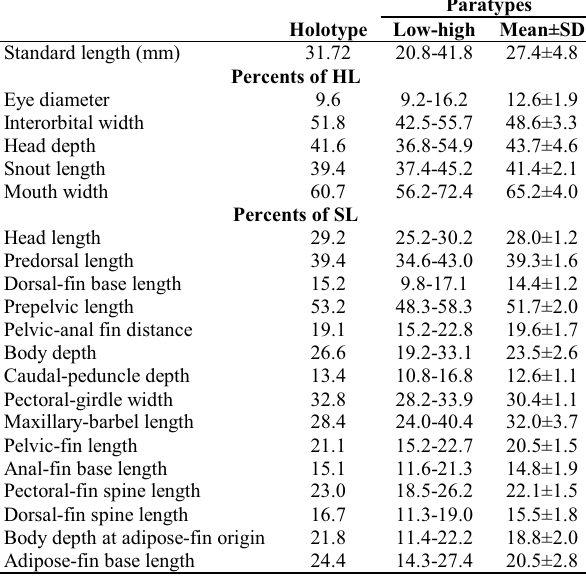
Table 1. Morphometric data of Microglanis garavelloi from Upper rio Paraná basin. Standard length (SL) in mm, body proportions as ratios of SL or head length (HL). SD = stan- dard